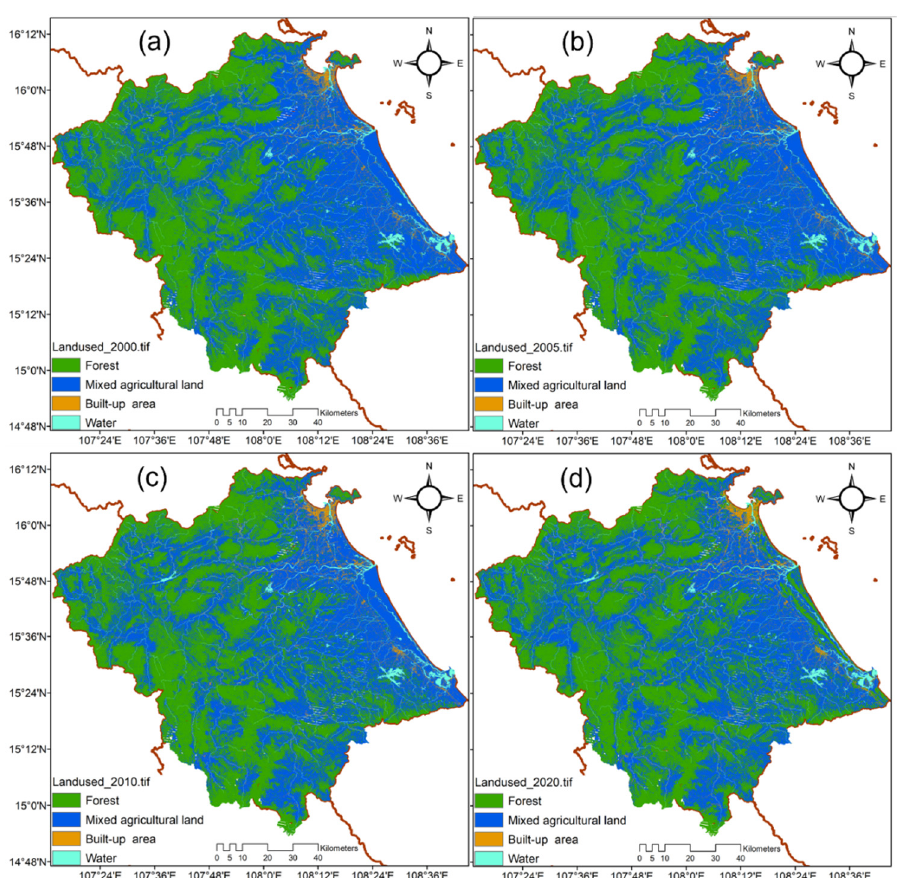
Figure 2. The Land-use maps in ( a ) 2000, ( b ) 2005, ( c ) 2010, and ( d ) 2020 for the study area.